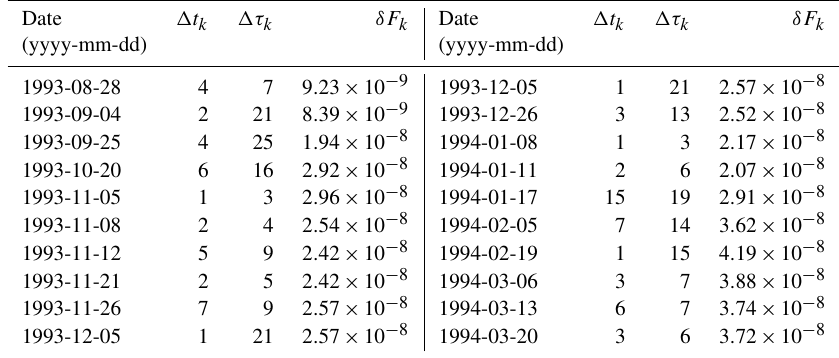
Table B1. The start date, duration ( (cid:49)t k , in d), and period between each event ( (cid:49)τ k , in d) for each Mistral event ( k ) and event strength, ( δF k , in s − 2 d − 1 ) for the preconditioning phase of the NEMO simulation period of 1 June 1993 to 31 May 1994.